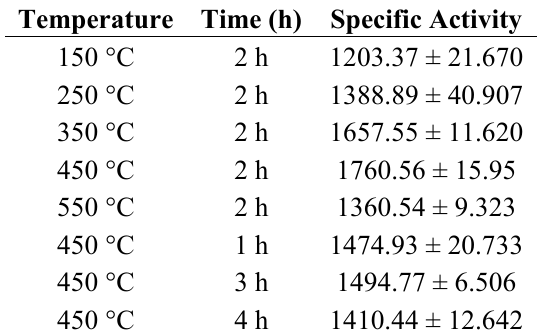
Table 1. Specific activity of Au/Al 2 O 3 catalysts calcined at different temperatures and